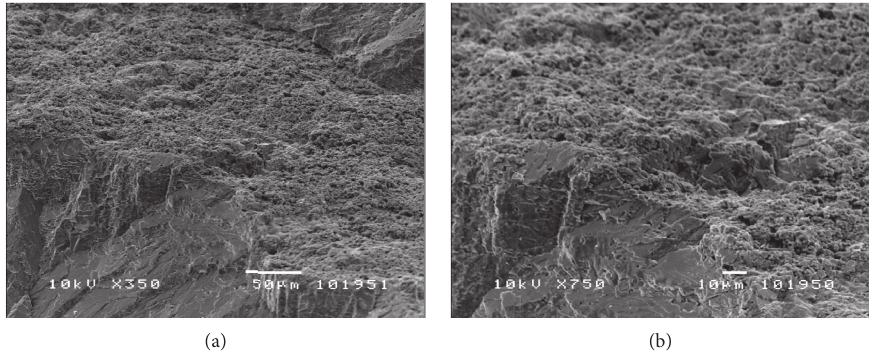
Figure 19: Marble fracture morphology. (a) Microscopic fracture morphology, × 350. (b) Microscopic fracture morphology, × 750.